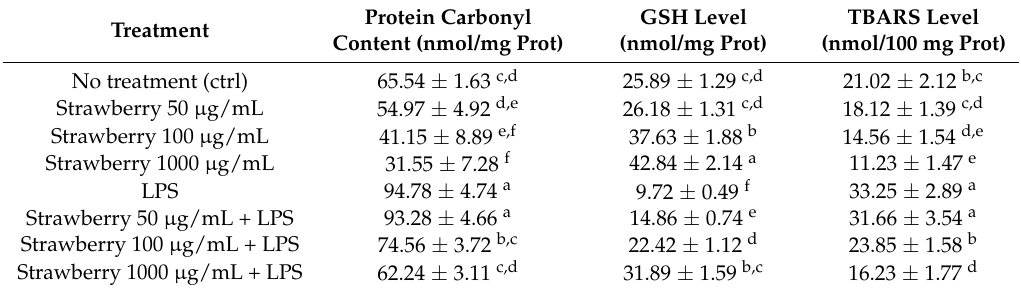
Table 2. Protein and lipid oxidation markers (protein carbonyl content, GSH and TBARS levels) in HDF cells treated with different concentrations of strawberry extracts (50, 100, 1000 µ g/mL) for 24 h, LPS (10 µ g/mL) for 24 h and with different concentrations of strawberry extracts and then with LPS. Columns belonging to the same set of data with different superscript letters are significantly different ( p < 0.05).